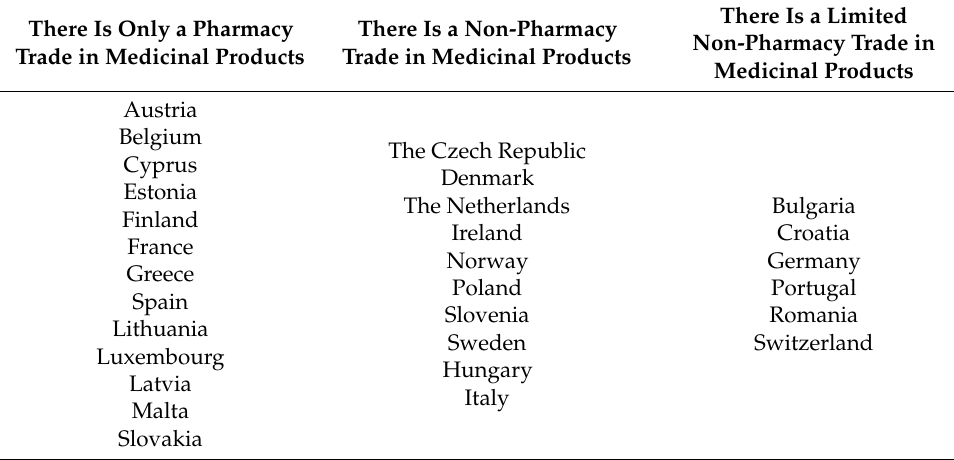
Table 1. Comparison of availability of medicines outside of pharmacies in the European